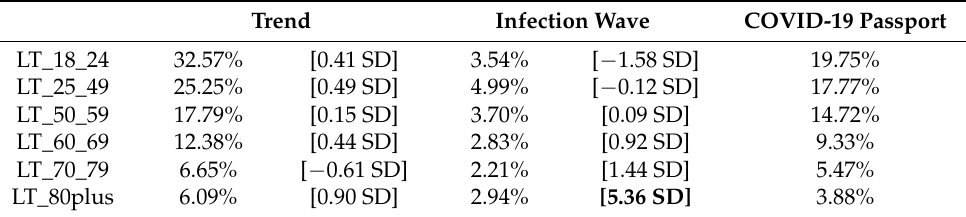
Table 2. Percentage of Lithuanians (subdivided into age groups) that received the first dose of the COVID-19 vaccine in the period 2021-W22 to 2022-W21, split according to the implied motivation mechanisms, with information in brackets by how many standard deviations this value diverges from the values observed in Poland. Note the outlier in